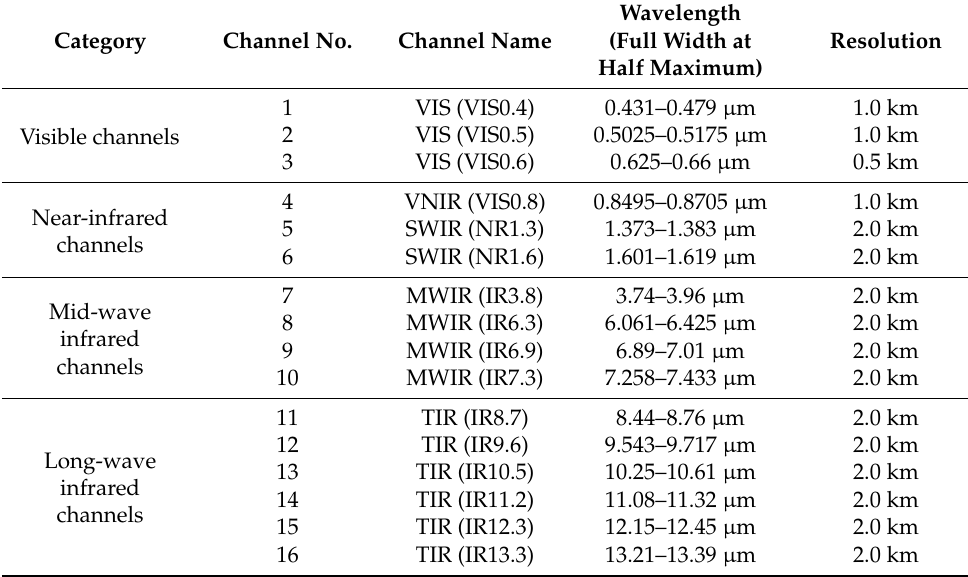
Table 1. Specifications of the GEO-KOMPSAT 2A Advanced Meteorological Imager (GK2A/AMI) spectral channels.